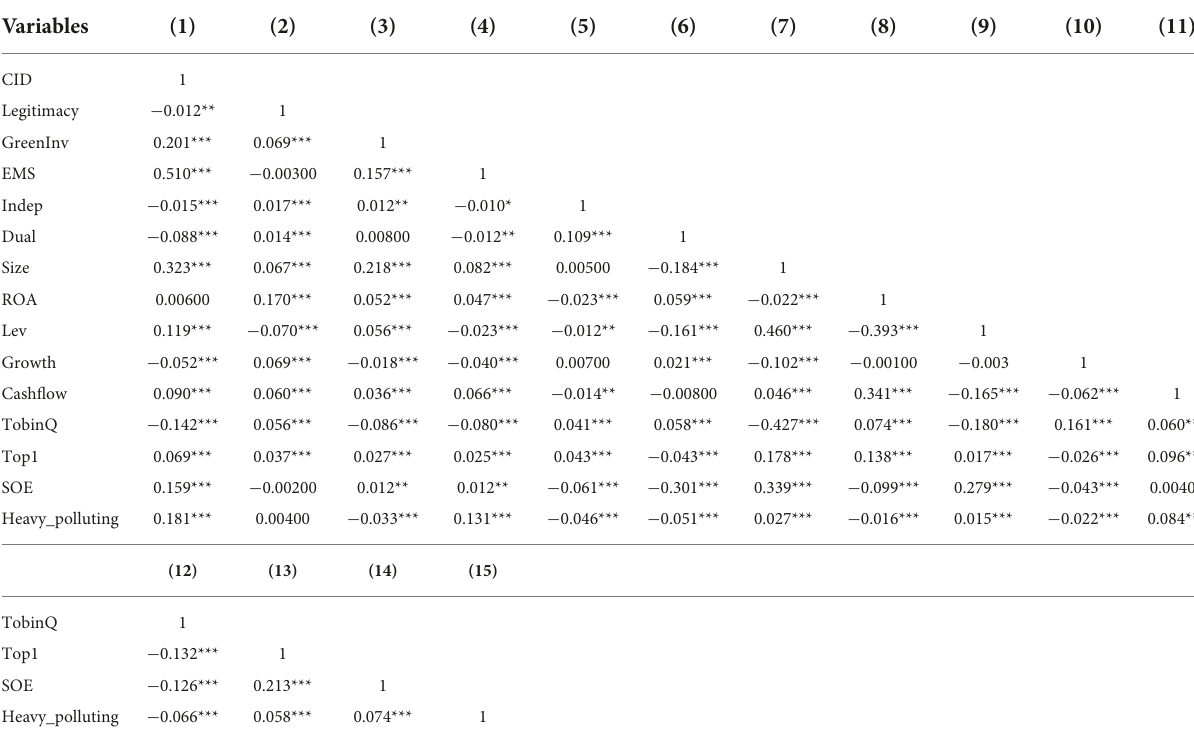
TABLE 3 Pearson correlation